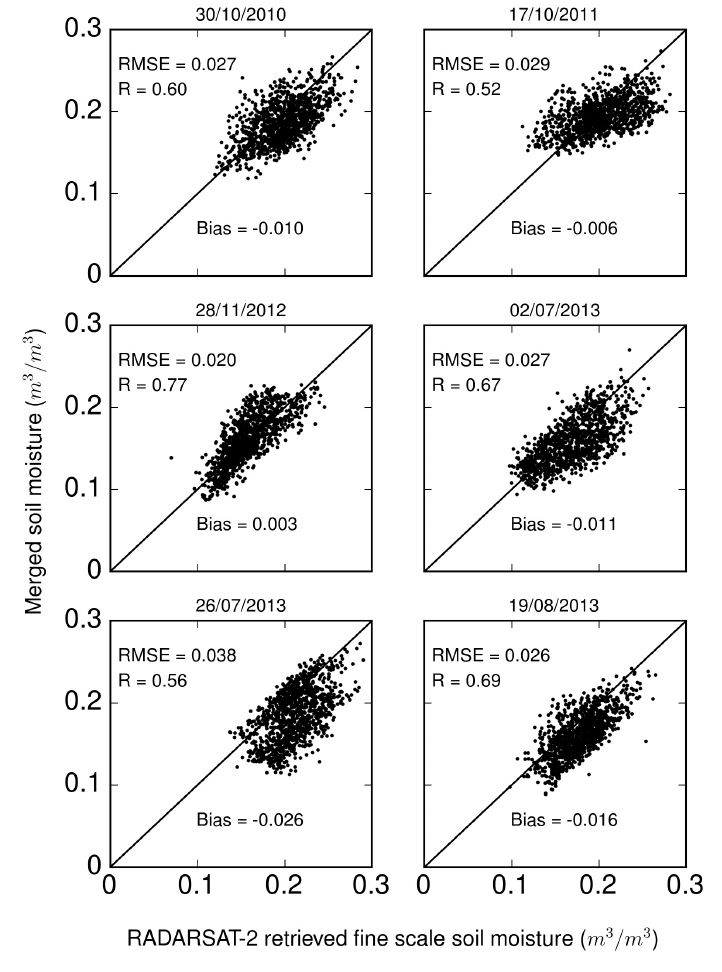
Figure 17. Comparison of the merged soil moisture with the RADARSAT-2 retrieved soil moisture at a spatial resolution of 500 m for the C-Linear